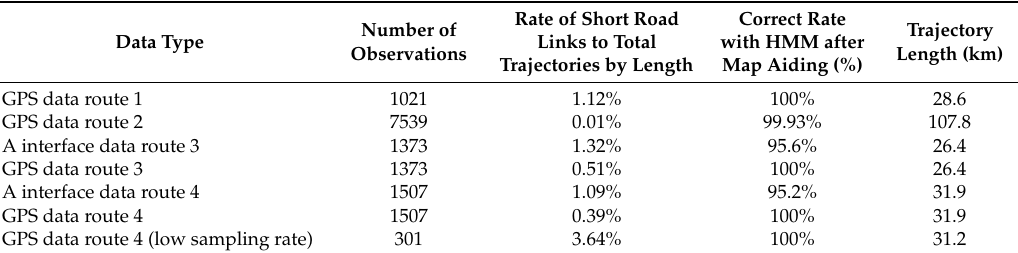
Table 2. Comprehensive statistical result of all verification test.